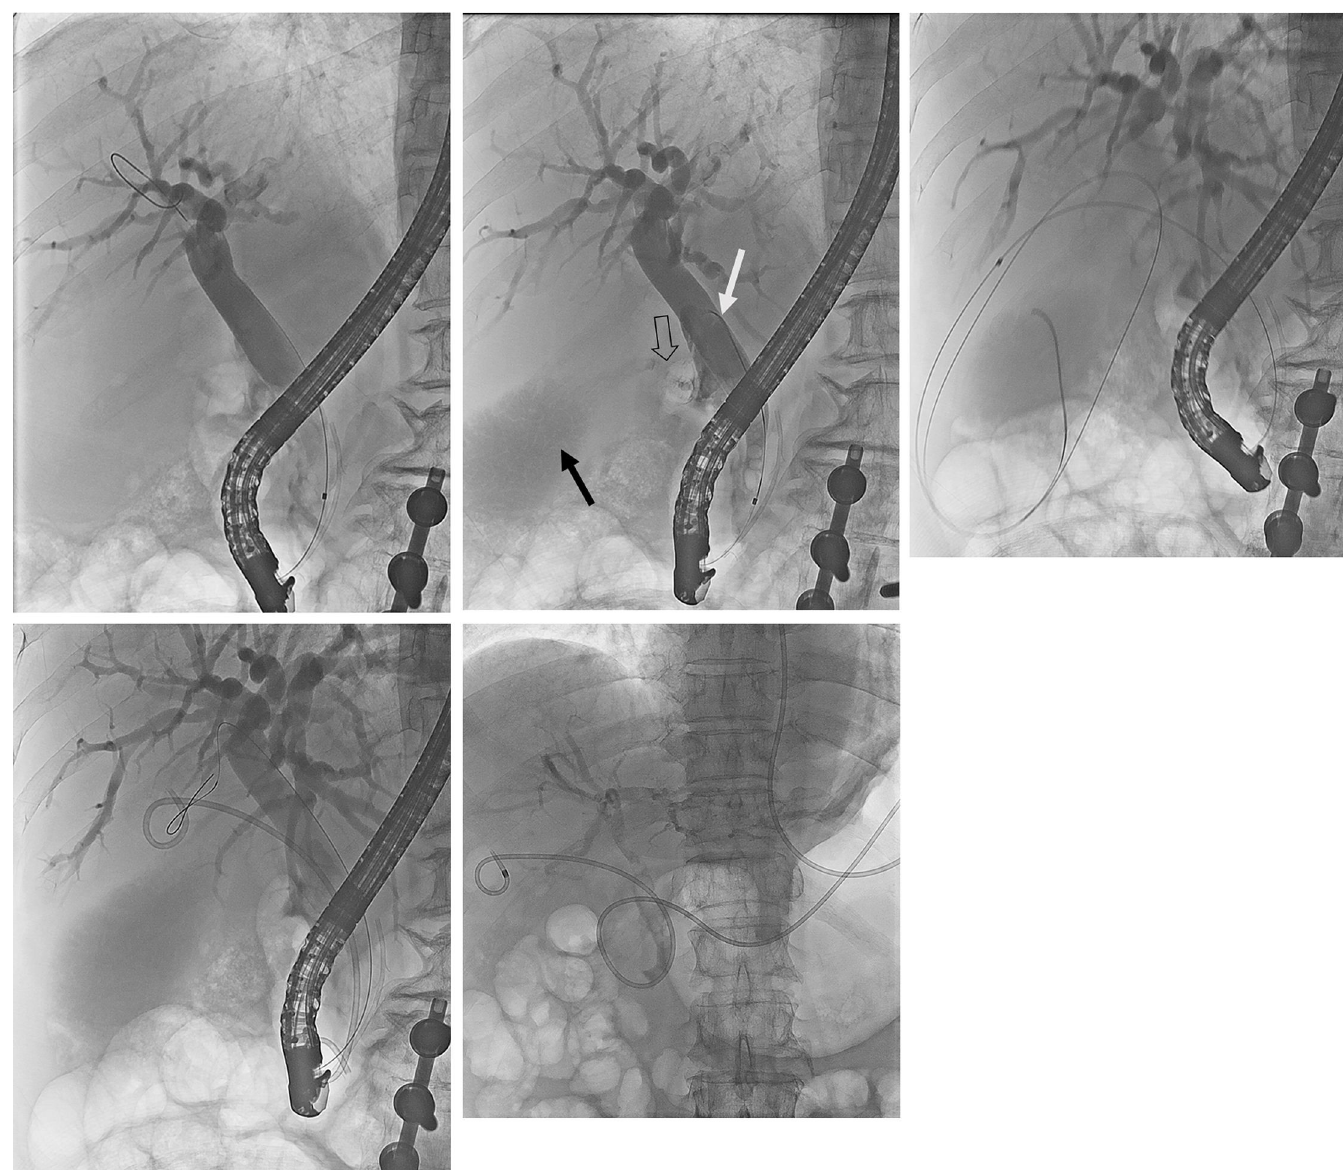
Fig 1. Endoscopic transpapillary gallbladder drainage via endoscopic transpapillary gallbladder stenting or endoscopic naso-gallbladder drainage A) Cholangiogram showing no visible cystic duct, B) Visible gallbladder (black arrow) and cystic duct (open arrow) after selective guidewire cannulation (white arrow) into the cystic